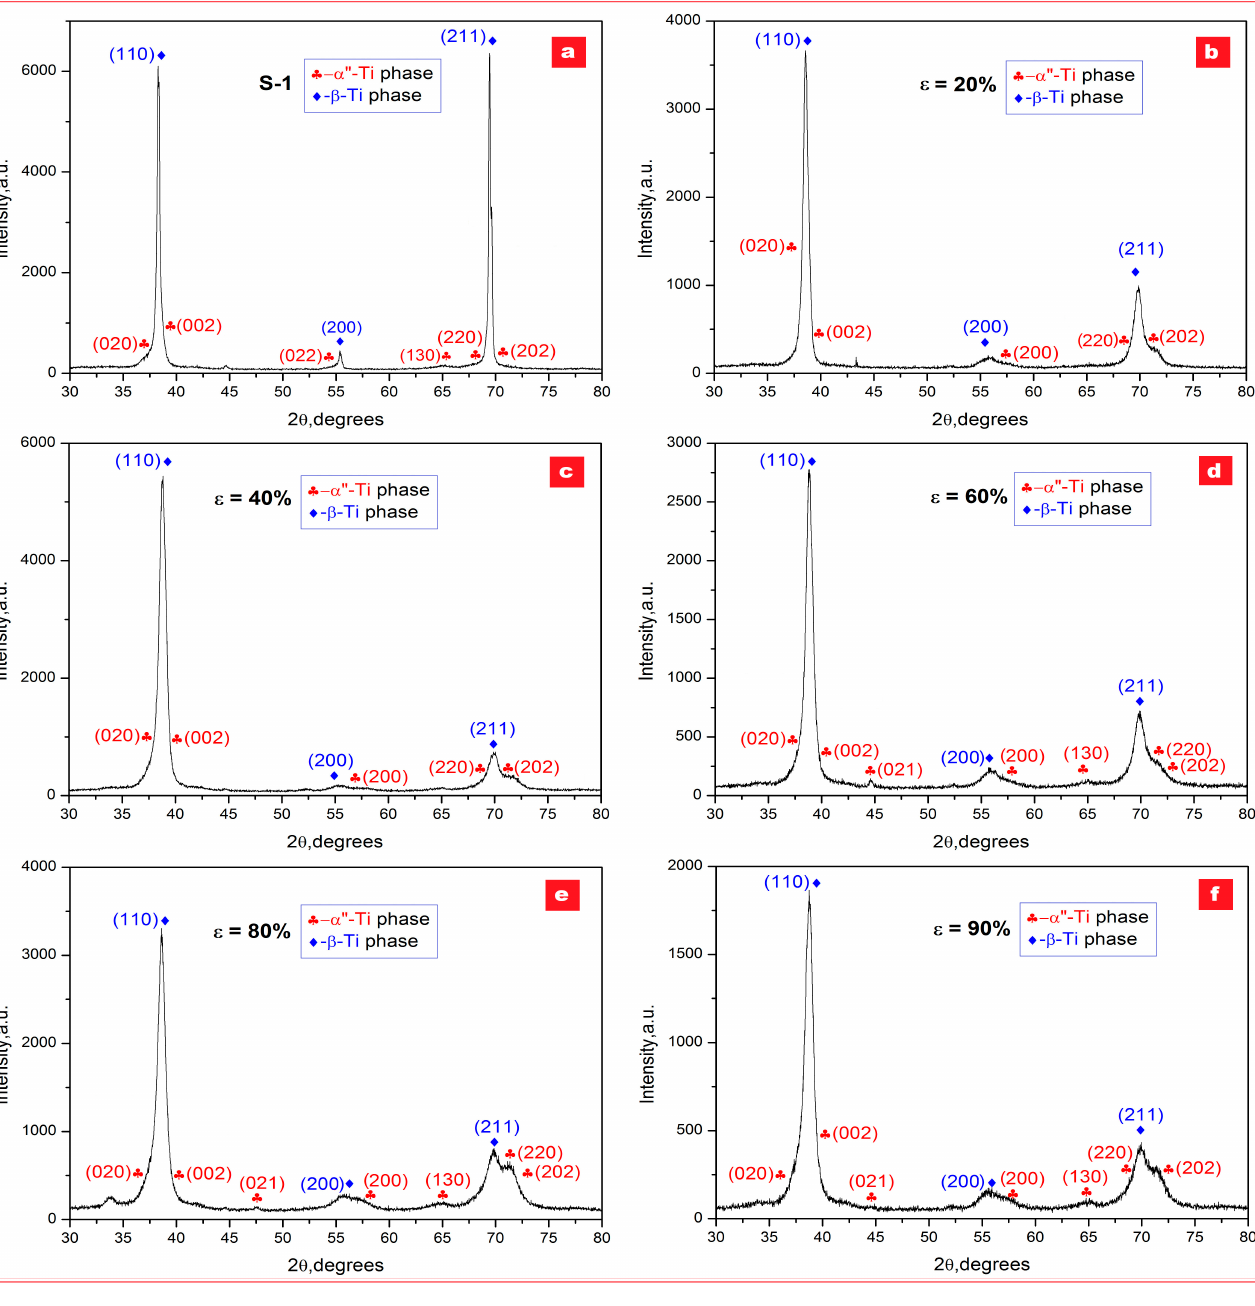
Figure 2. XRD pa tt erns of the Ti29Nb-9Ta-10Zr alloy corresponding to following stages: ( a ) initial state—S-1; ( b ) MPR processed with ε = 20%; ( c ) MPR processed with ε = 40%; ( d ) MPR processed with ε = 60%; ( e ) MPR processed with ε = 80%; ( f ) MPR processed with ε = 90%.